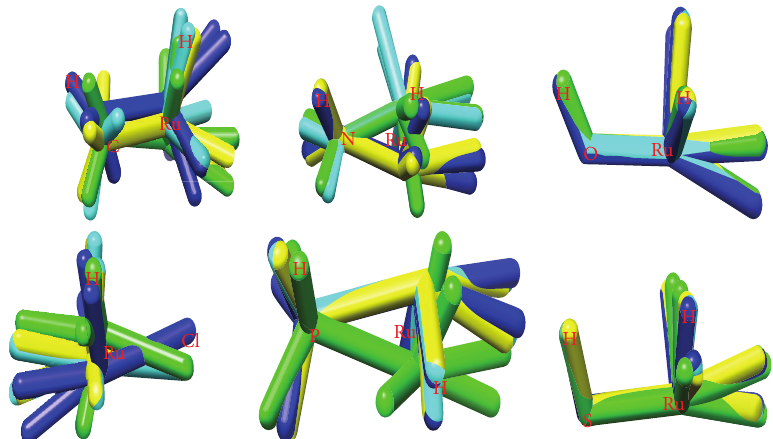
Figure 2: The superposition of different model of Ru-L bonds obtained using MP2 (green), CCSD (blue), PBE (yellow), and B3LYP (cyan) to determine the RMSD of the whole geometries after the optimization of their respective geometries.